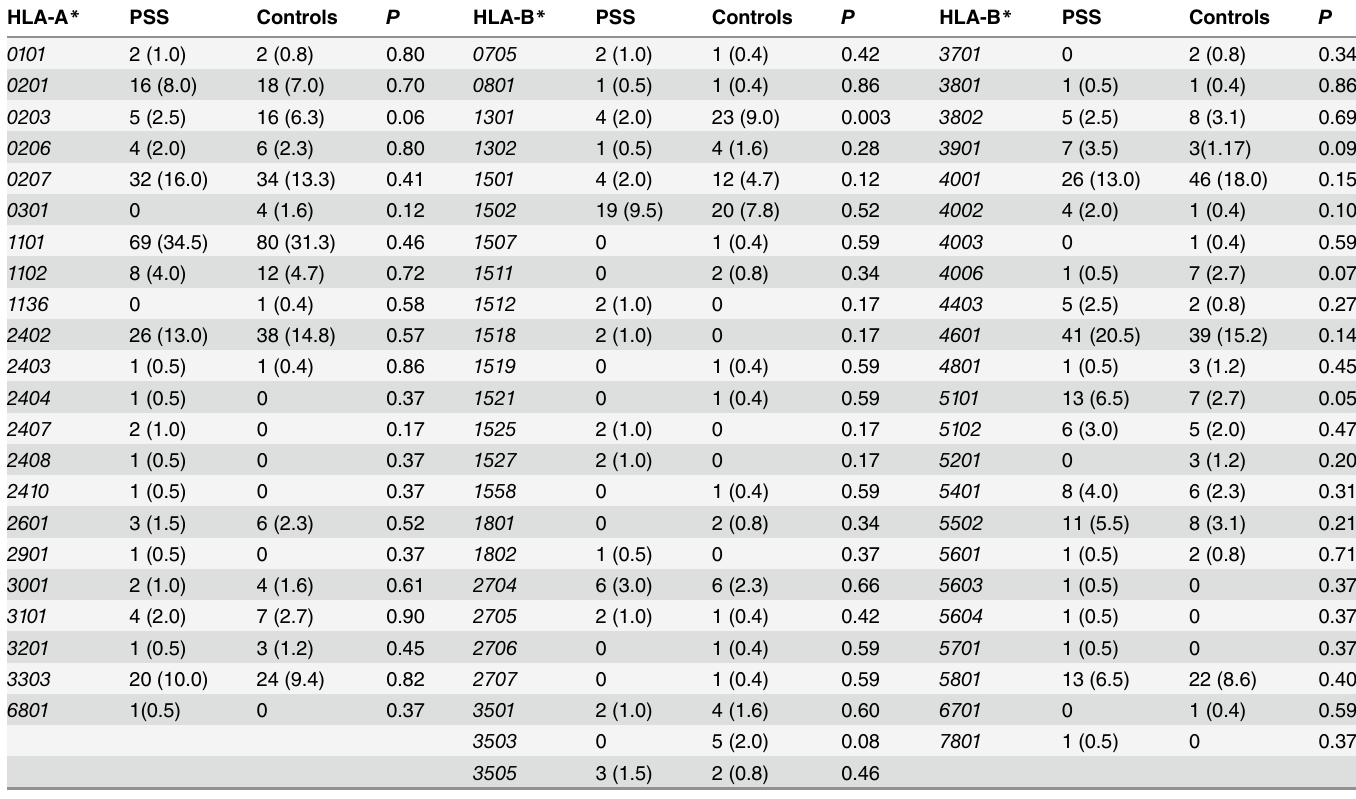
Table 2. Frequencies of HLA-A and-B alleles in PSS cases and